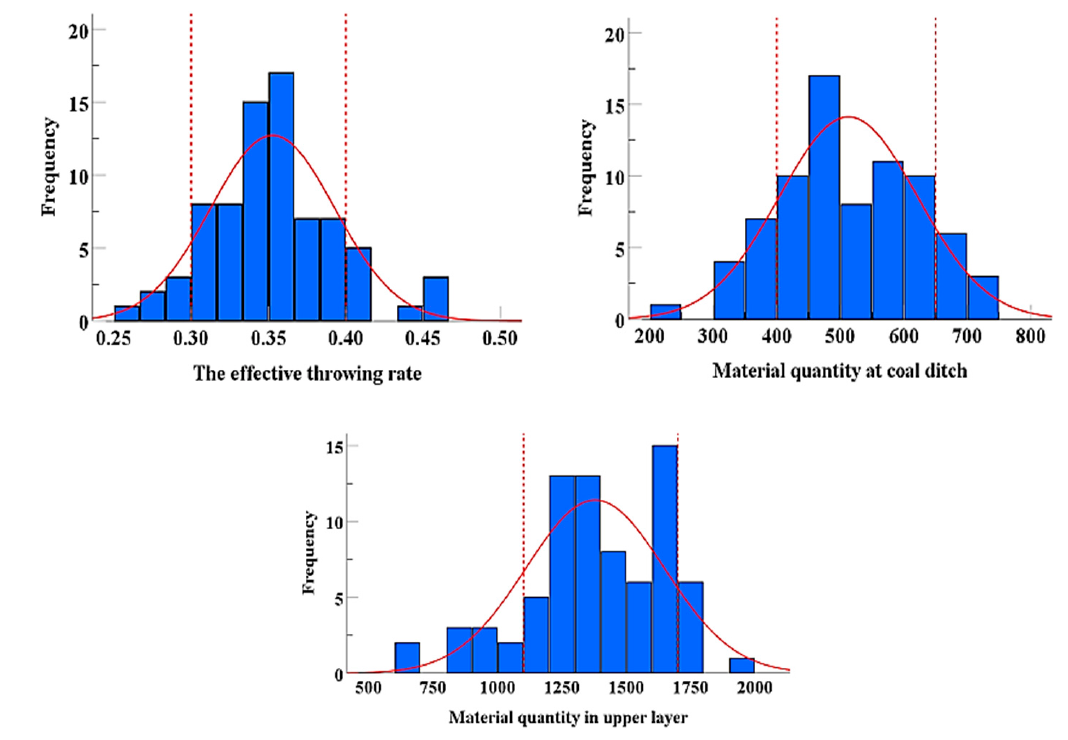
Figure 12. Statistical analysis of a sample set with step height of 45 m.